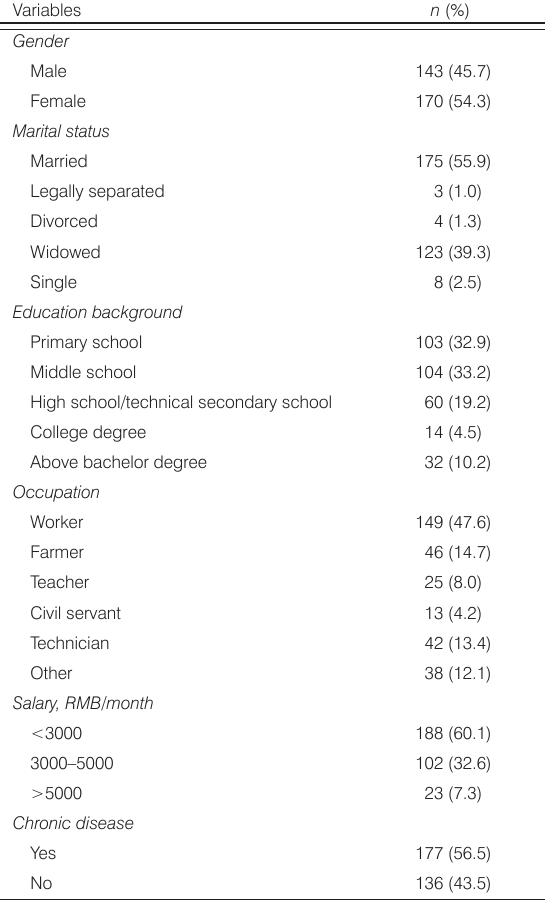
Table 1. Demographic characteristics of 313 older